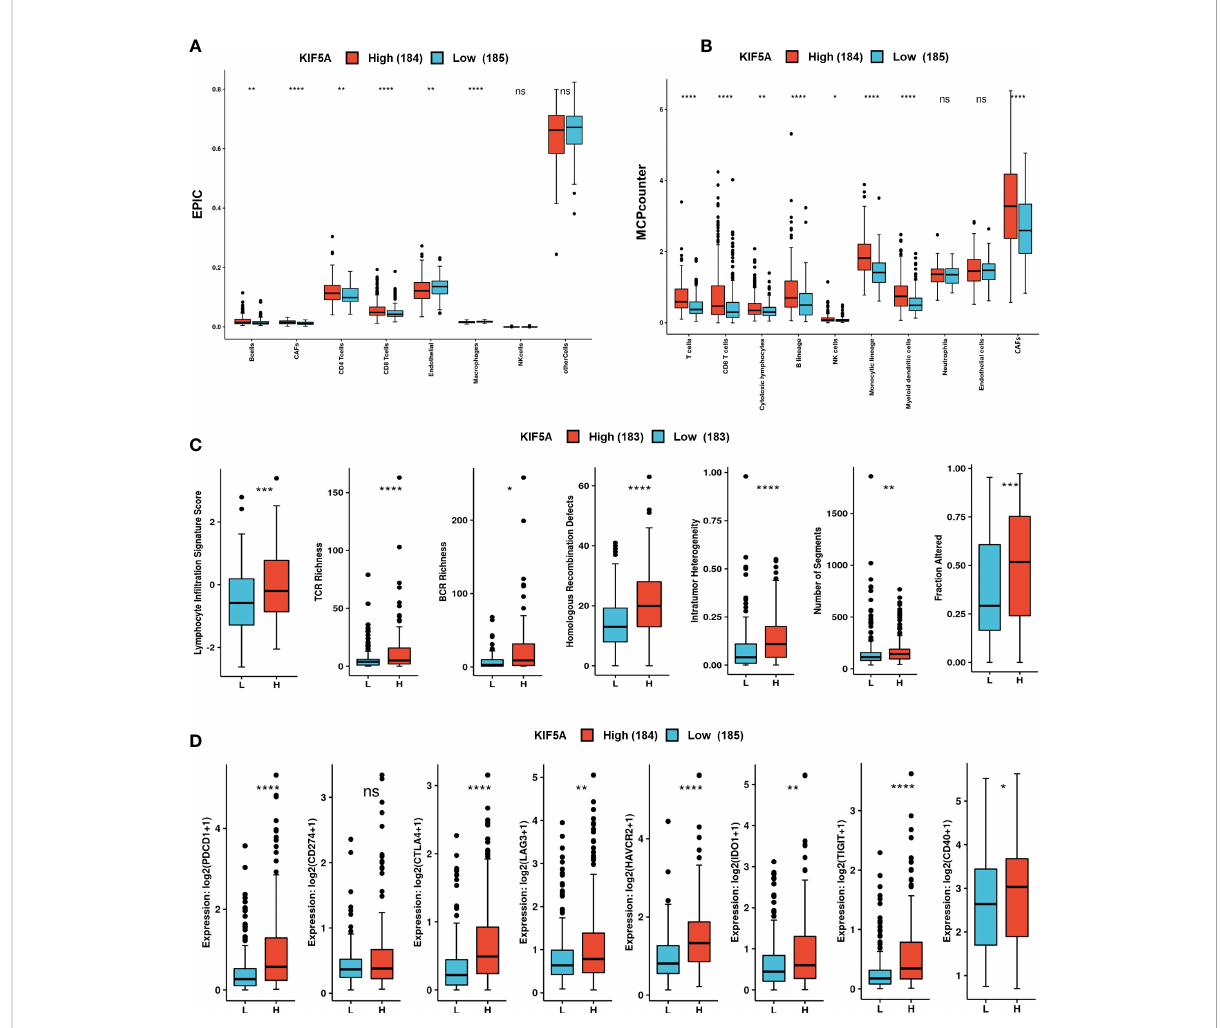
FIGURE 7 Upregulated KIF5A predicts unique TME in LIHC. (A) Immune in fi ltration analyses based on the EPIC method. (B) Immune in fi ltration analyses based on the MCPcounter method. (C) Comparison of immune scores between KIF5A-high and low group. (D) Comparison of immune checkpoint molecules between KIF5A-high and low group. **** p < 0.0001, *** p < 0.001, ** p < 0.01, * p < 0.05, ns not signi fi